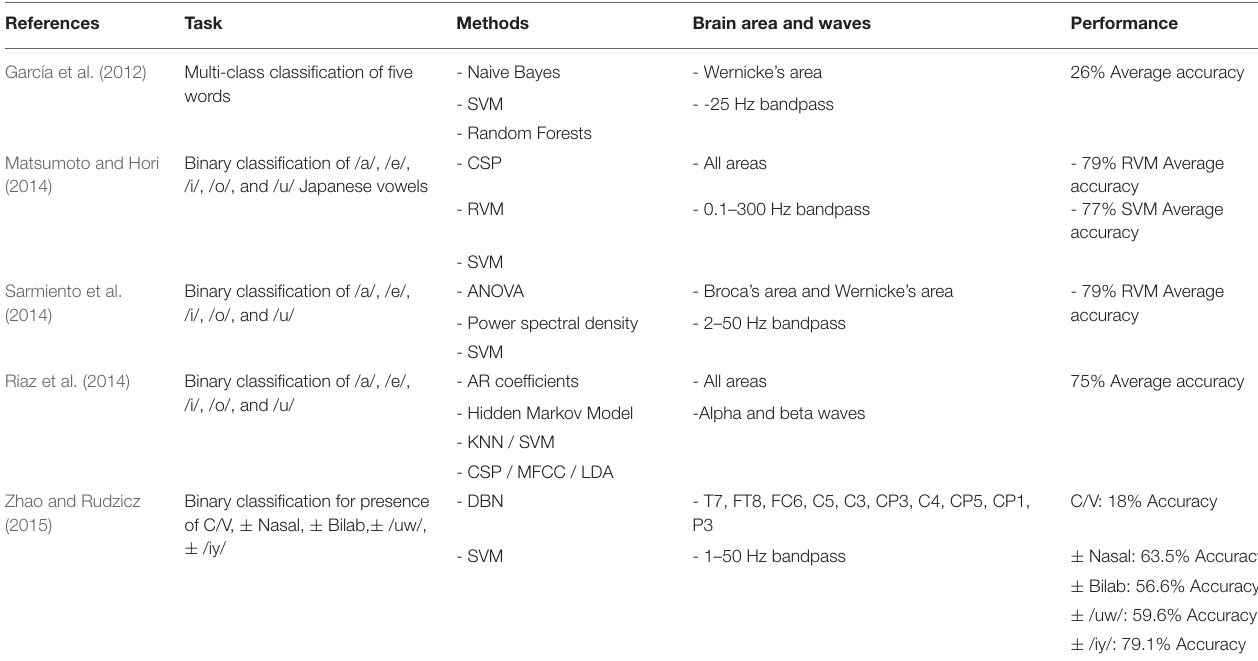
TABLE 2 | Imagined speech classification methods summary